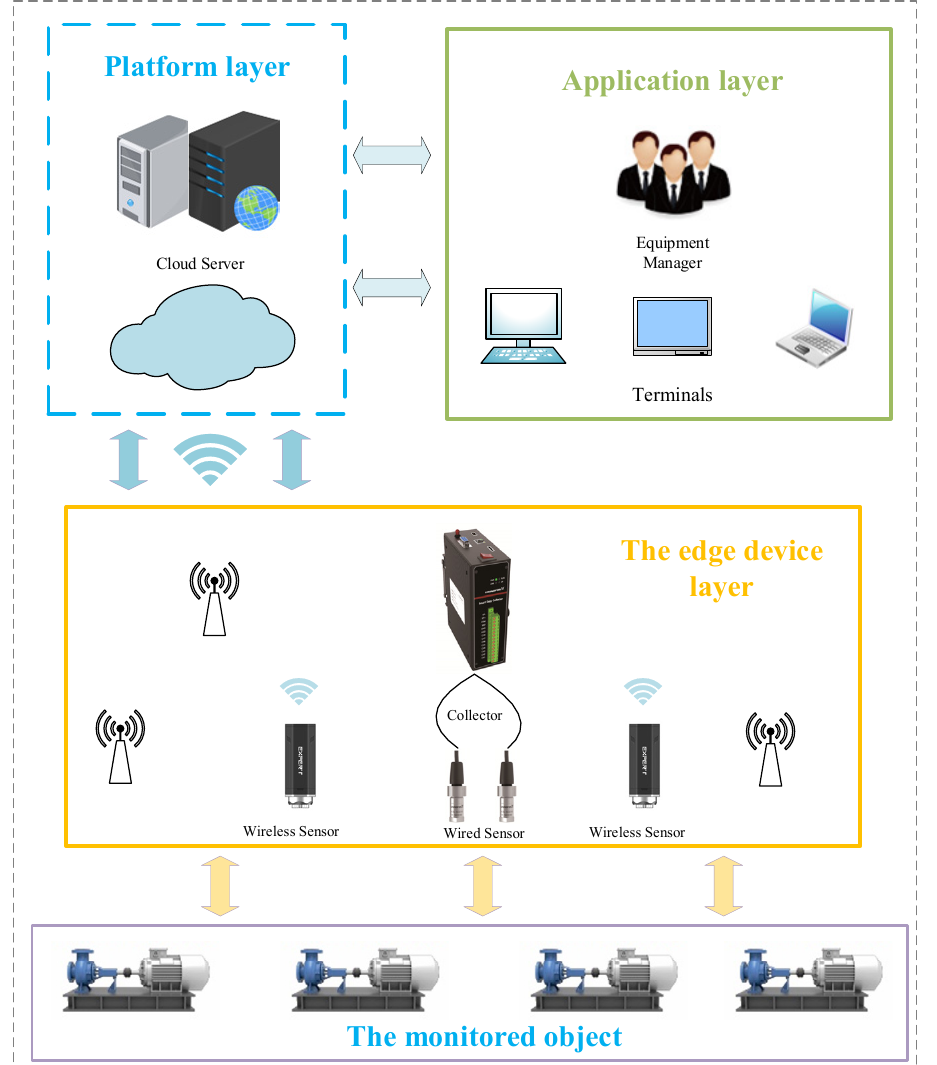
Figure 5. System topology diagram.